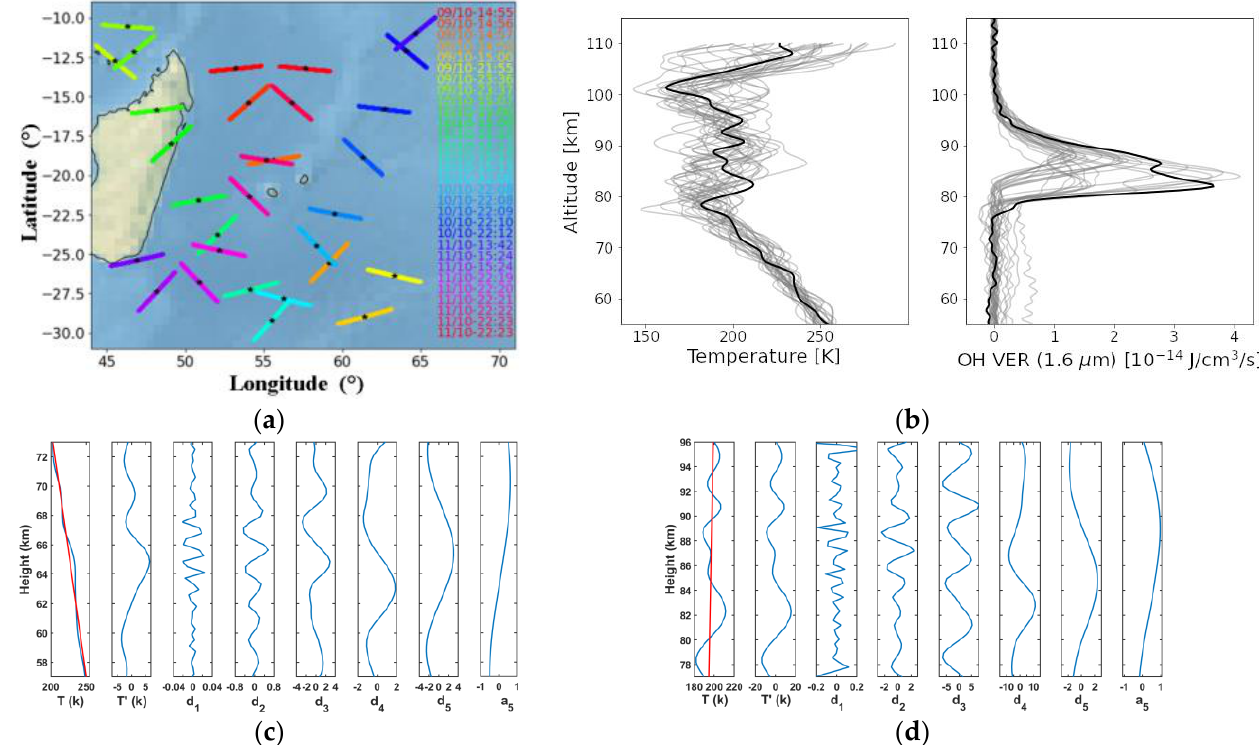
Figure 21. ( a ) SABER profiles from 9 October 2017 at 1455 UTC to 11 October 2017 at 2223 UTC in the region of the study. Stars mark the tangent point corresponding to an altitude of 87 km; In gray, ( b ) temperature (left panel) and OH VER (right panel) at 1.6 µ m profiles corresponding to Figure 21a. Solid black lines show the profiles (orbit 85851) on 9 October 2017 at 1459 UTC; Fifth-order MRA applied to vertical temperature at heights of ( c ) 57–73 km in the upper mesosphere and ( d ) 77–96 km in the mesopause—lower thermosphere. From left to right, panels represent the vertical temperature profile (blue) and the linear trend (red), the temperature perturbations T’, the five details and the approximation a 5 .